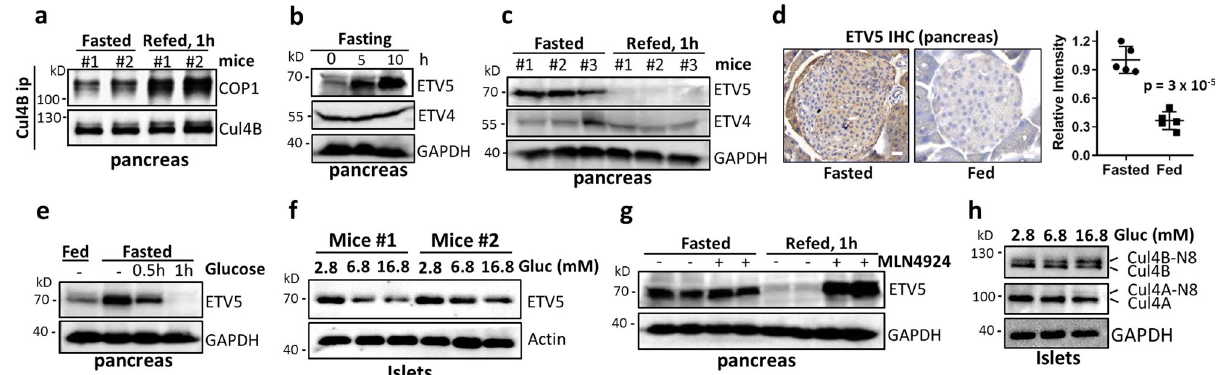
Fig. 5 ETV5 as a CRL4 COP1 regulated physiologic checkpoint for nutrient/glucose-induced insulin secretion. a Refeeding induces CRL4B – COP1 complex formation in overnight-fasted mice. b Levels of ETV4 and ETV5 in the pancreas of mice fasted for the indicated period. c Levels of ETV5 in the pancreas of overnight-fasted mice, with/without refeeding. d Immunostaining of ETV5 in pancreatic tissues of fasted or fed mice ( n = 5, *** p < 0.001, Student ’ s t test). Data are presented as mean ± SEM. e Effect of glucose (1.5 mg/kg) on ETV5 levels in pancreas. Scare bars, 0.2 μ m. f Levels of ETV5 in isolated islets after exposure to different concentrations of glucose for 1 h. g Levels of ETV5 in the pancreas of starved/refed mice with/without MLN4924 pretreatment (15